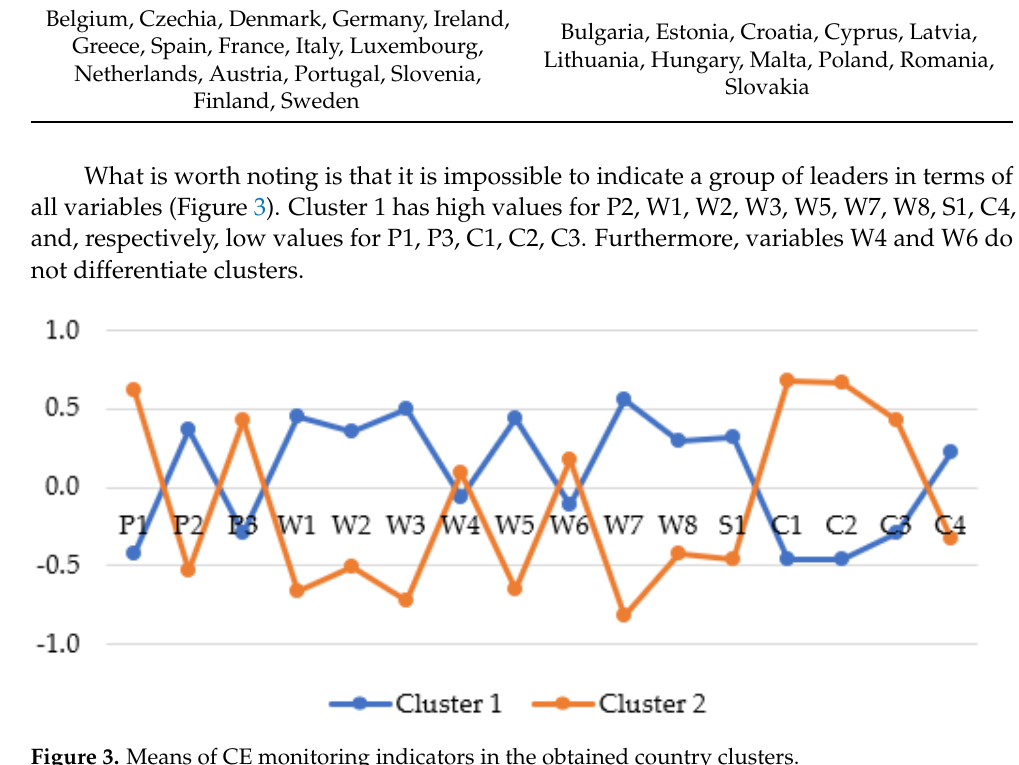
Figure 3. Means of CE monitoring indicators in the obtained country clusters.